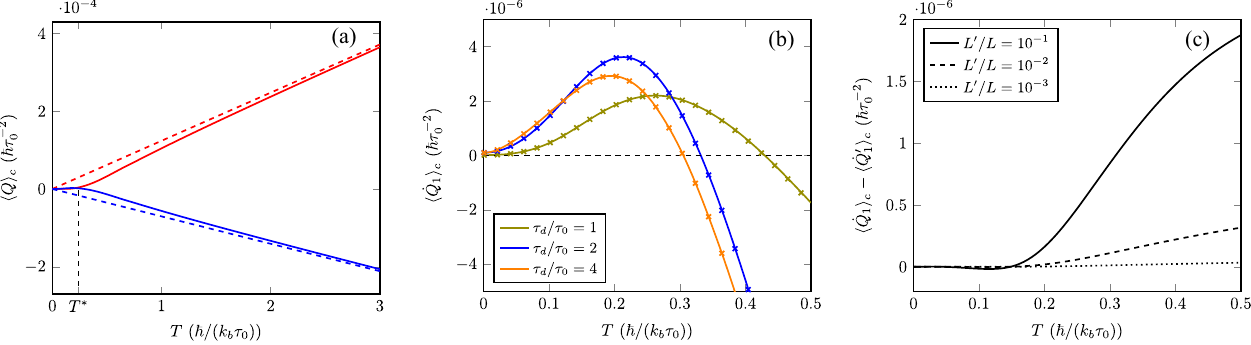
FIG. 6. (a) Comparison of classical (dashed lines) and quantum (solid lines) heat currents for the circuit of Fig. 3 [ Δ C=C ¼ 10 − 1 , _ Q ω 10 − 2 ð 2 π = τ τ 2 τ T for different values of τ = τ d ¼ 0 Þ , and d ¼ 0 ]. (b) h 1 i c as a function of d 0 . Solid lines correspond to the heat currents computed for the overdamped circuit of Fig. 3, while crosses correspond to the circuit of Fig. 7 with L 0 =L ¼ 10 − 3 . (c) Difference between the heat currents obtained for the two circuits for different values of L 0 =L .